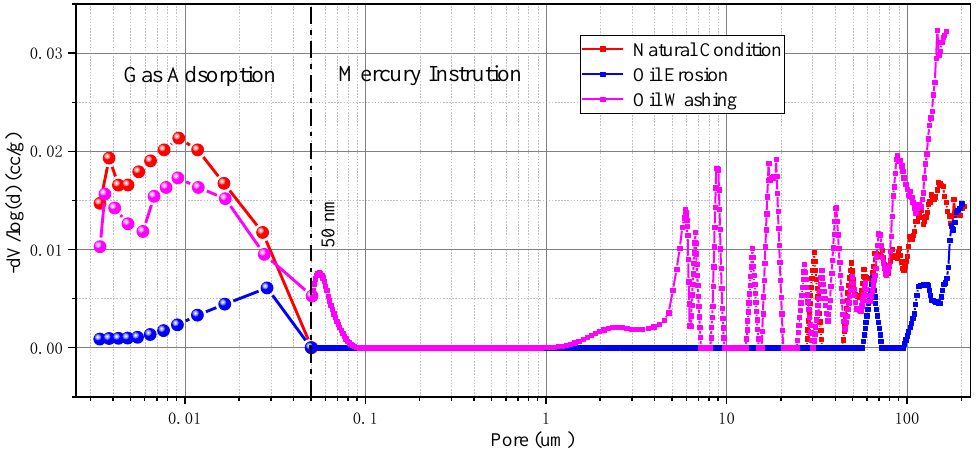
Figure 12. The total pore size distribution of rock salt samples under different conditions.